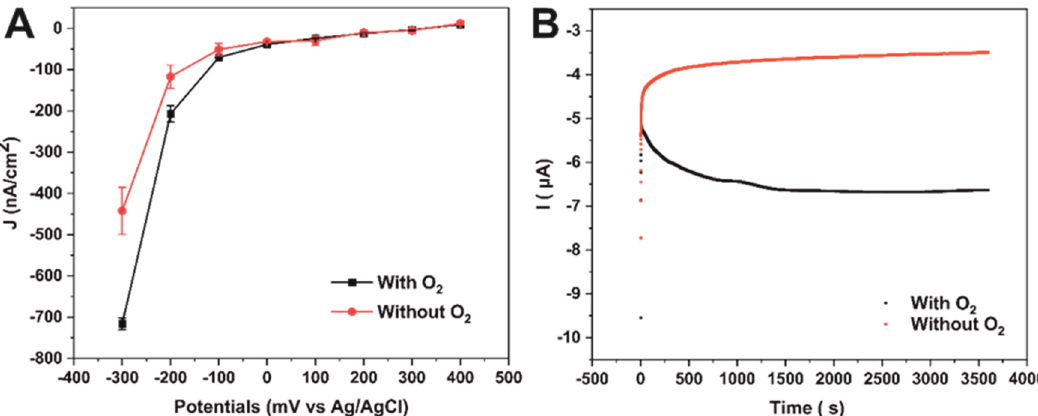
Figure 6. Photochronoamperometric analysis of the biohybrid FTO/SLG/pyr-NTA-Co 2+ /His 6 -PsaD-PSI nanoassemblies. ( A ) Photocurrent densities obtained from the freshly prepared samples in the presence (black) or absence (red) of oxygen under 30 s ‘light ON/OFF’ cycles. These data were obtained for 2 independent samples (n = 2). ( B ) Photochronoamperomet- ric curves recorded for the representative FTO/SLG/pyr-NTA-Co/His 6 -PsaD-PSI sample at − 0.3V during 1 h continuous illumination (100 mW·cm − 2 ).